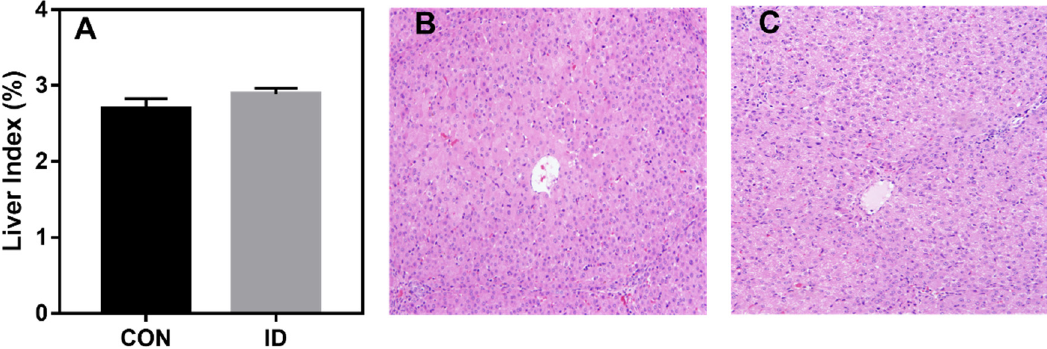
Figure 2. Enriched pathways of serum metabolites in neonatal piglets affected by iron deficiency. Each node marks a pathway, with larger sizes and darker colors representing higher pathway enrichment and higher pathway impact values.